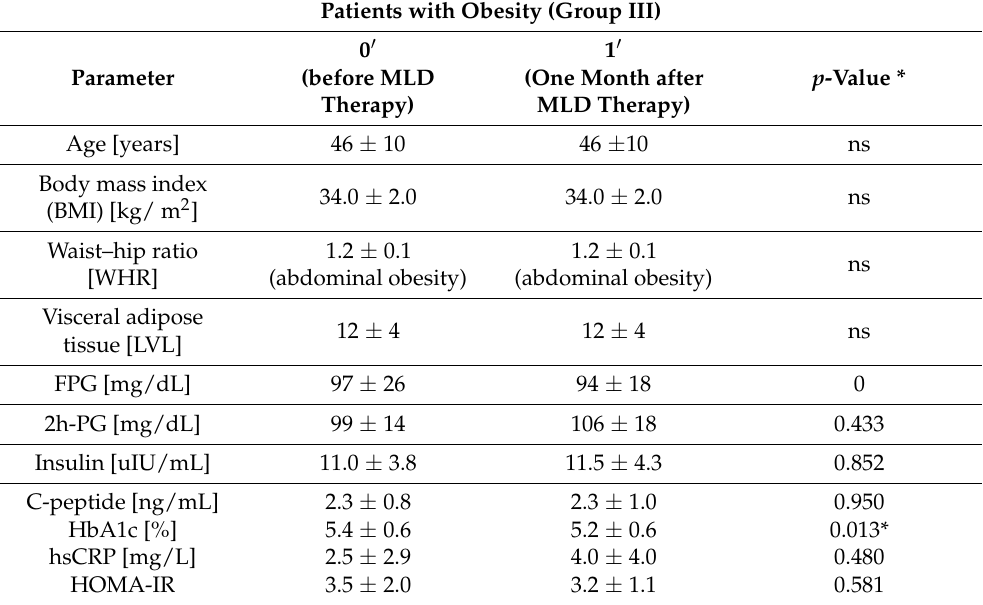
Table 5. Biochemical parameters before (0 (cid:48) ) and one month after (1 (cid:48) ) MLD therapy in a patients with obesity (group